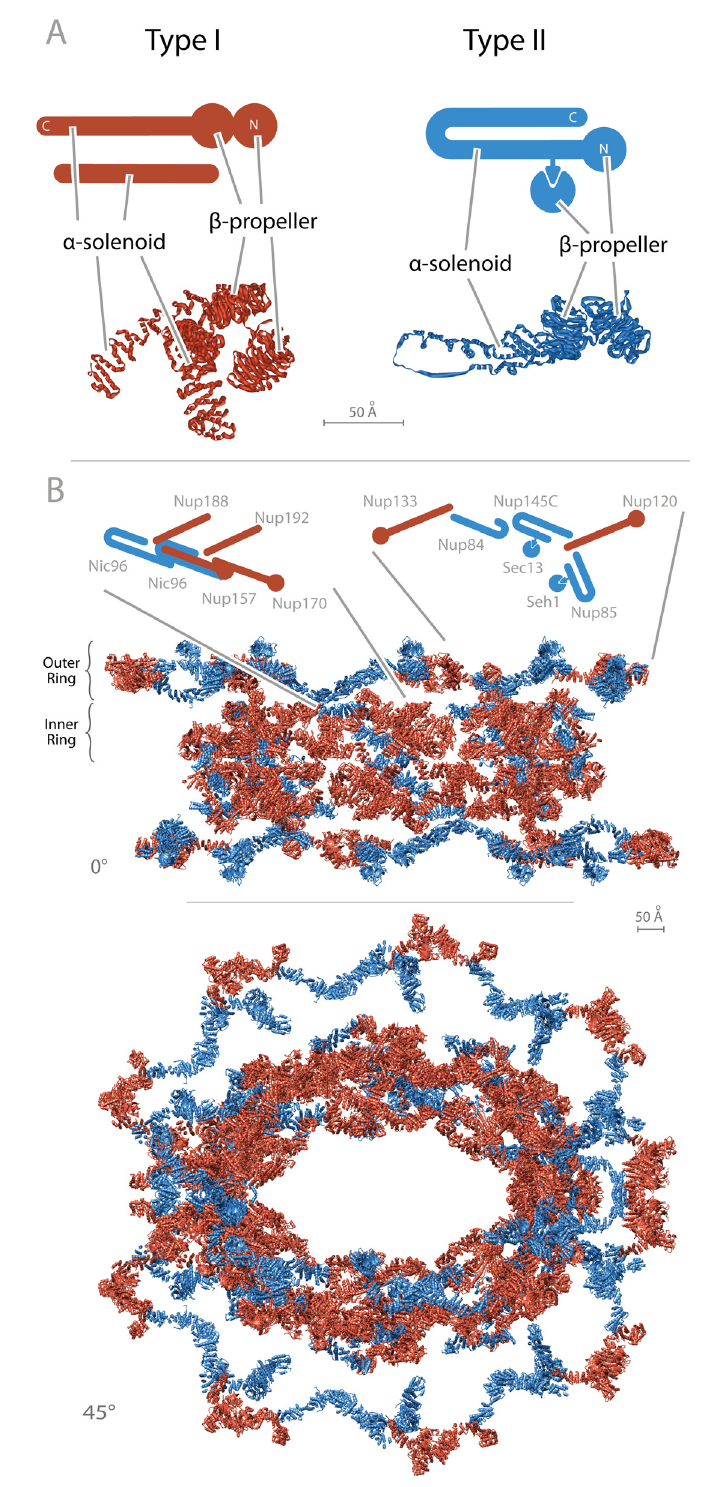
Figure 2. Type I and type II coat protein architectures and locations within the nuclear pore complex. ( A ) Examples of type I and type II architectures are shown. Type I coats are red and type II are blue. Idealized structures appear above, and examples of structures determined by x-ray (COPI subunits pdf:5A1U and COPII subunits pdf:4BZJ as representatives of type I and type II, respectively) appear below. Note the characteristic β -propeller head and α -solenoid tail in both type I subunits, the α -solenoid adaptin-like subunit in type I, and the clear presence of a discontinuity and loop in the α -solenoid following the β -propellers in type II. ( B ) A section of the Saccharomyces cerevisiae nuclear pore complex structure is shown at the bottom, illustrating only the type I– and type II–related subunits. Note the intermixing of types within the overall